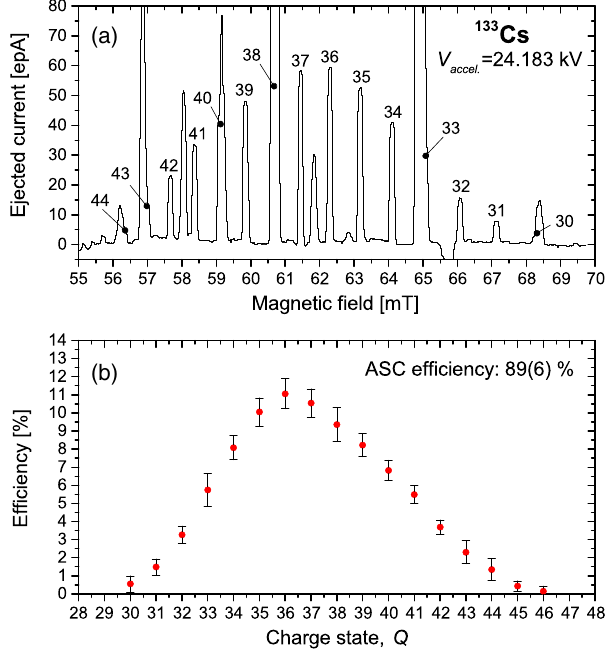
FIG. 8. Same as Fig. 6, but for 133 Cs.